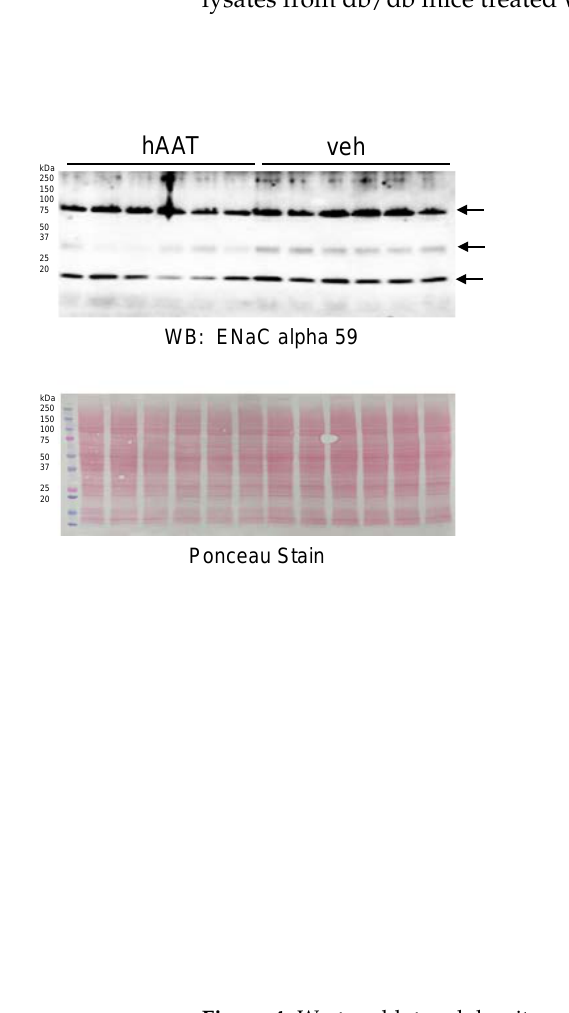
Figure 4. Western blot and densitometric analysis for ENaC alpha. ( A ). Western blot for ENaC alpha subunit protein expression. Eighty micrograms of total protein from kidney cortex lysates from hypertensive diabetic db/db mice treated with either hAAT or vehicle were resolved by SDS-PAGE and then transferred to nitrocellulose membranes which were blotted for ENaC alpha subunit protein expression. ( B ). Image J was used to obtain densitometry values for each band which were normalized to the Ponceau staining. N = 6 mice in each group. ** p <